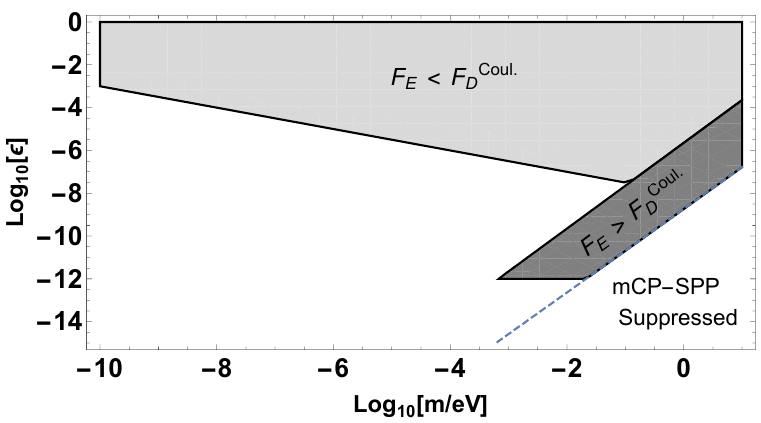
Figure 4 . (cid:31) exclusion regions based on energy-loss and B D and (4.10). A bound (cid:15) . 10 (cid:0) 12 is obtained for F mCP fermions are introduced directly without any inter-mCP dark interactions. F